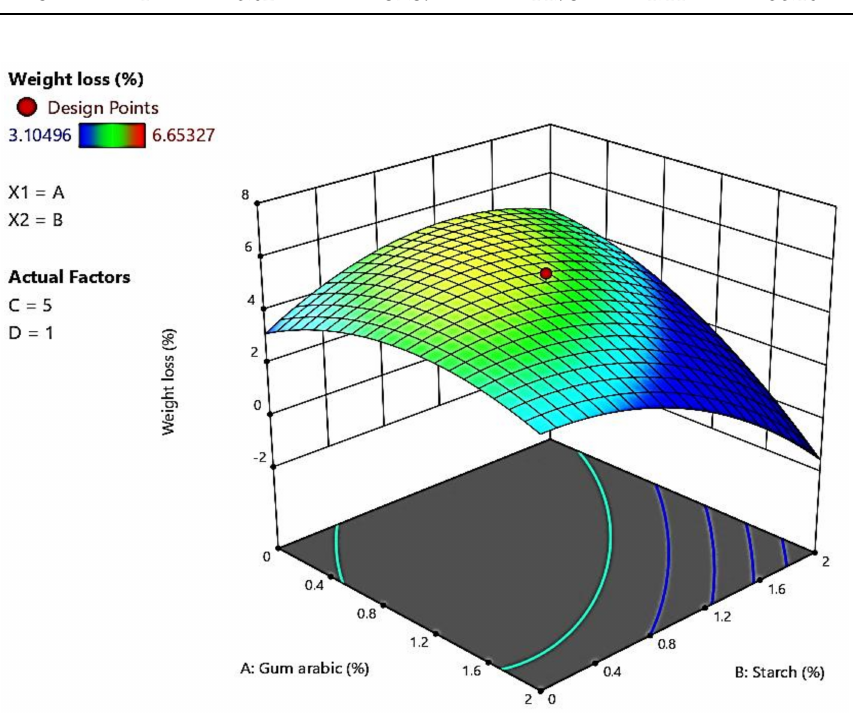
Figure 1. Response surface plot for weight loss (%) of coated “Wonderful” pomegranate as a function of gum arabic and maize starch